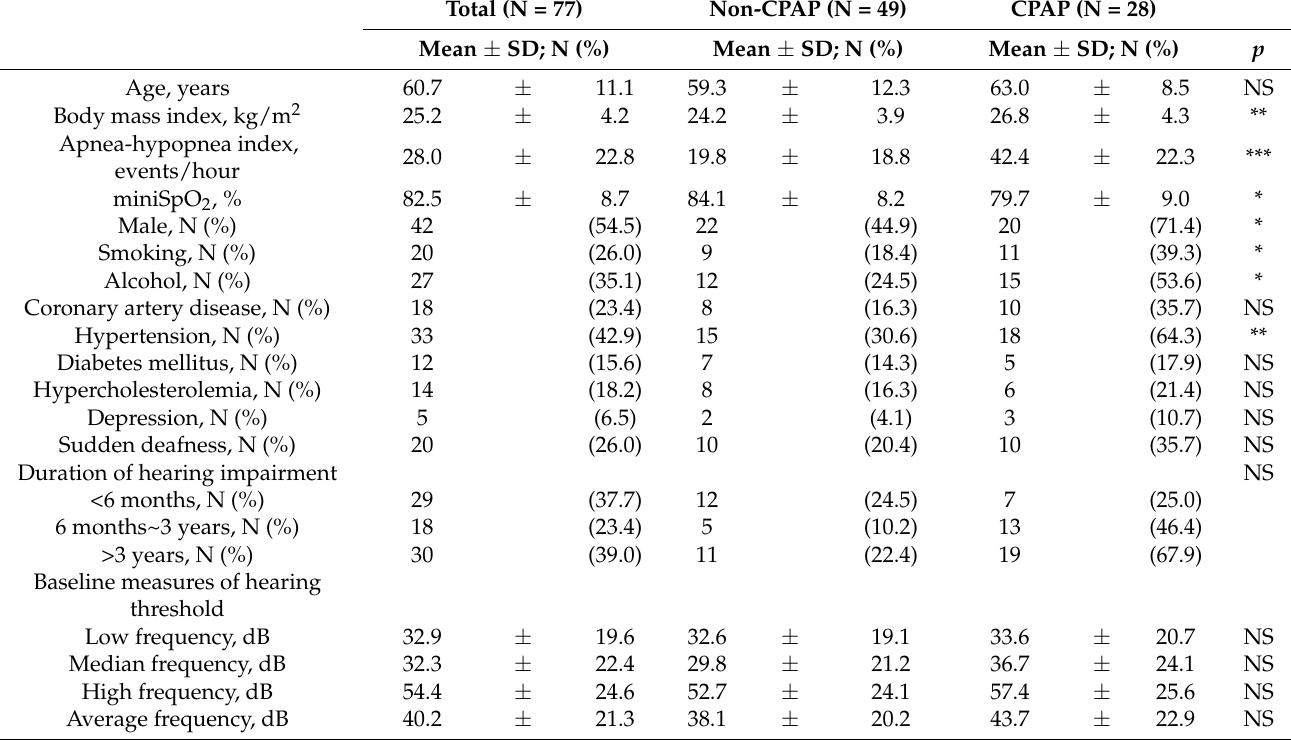
Table 1. Differences between non-CPAP group and CPAP group in anthropometric variables, comorbid diseases, history and severity of hearing impairment, and severity of sleep-disordered